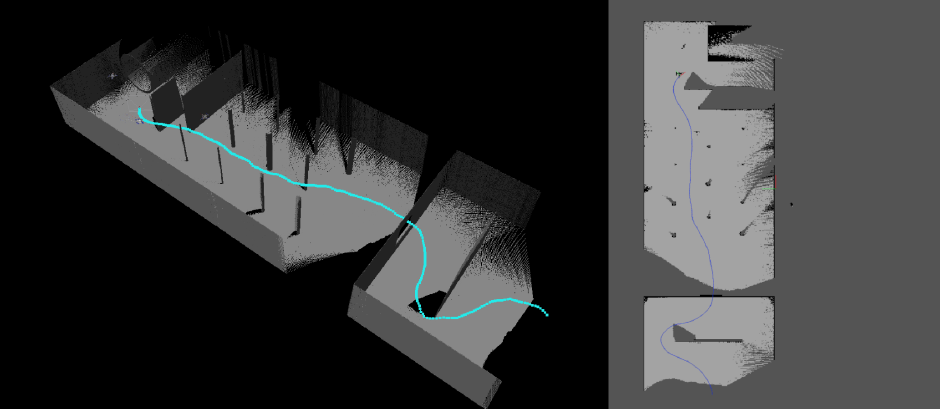
Figure 20. Visualization of the trajectory of UAV controlled by the SCAN algorithm (Area 1). The left image is 3D-SLAM and the right image is 2D